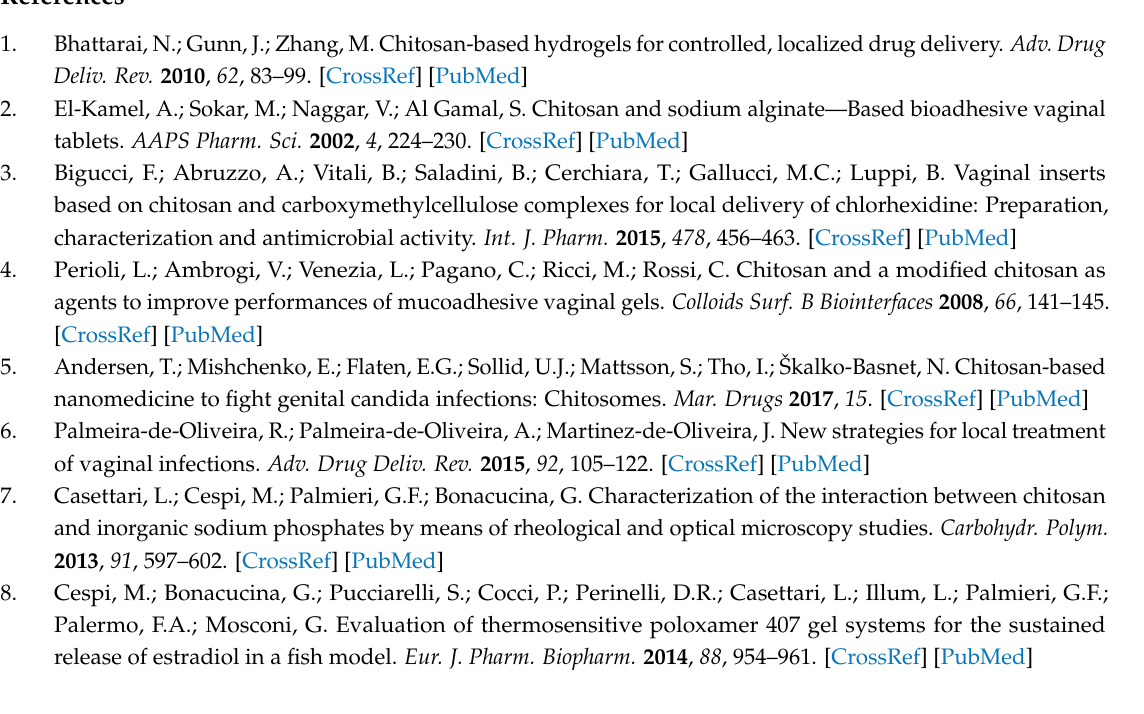
Figure S1: “Main effect” plot relative to the factors (CS % and CS/TPP ratio) influencing the size of nanoparticles, Figure S2: “Interactions plot” between the factors (CS% and CS/TPP ratio) influencing the size of nanoparticles, Figure S3: Hydrodynamic diameter (nm), counts (Kcps) and transmittance (%) of nanoparticles at different CS concentrations (0.1%, 0.5% and 1%; w/w ) and different CST/TPP ratio prepared in acetate buffer pH 5, Figure S4: Hydrodynamic diameter (nm), counts (Kcps) and transmittance (%) of nanoparticles at different CS concentrations (0.1%, 0.5% and 1%; w/w ) and different CST/TPP ratios prepared in acetate buffer pH 5.5, Figure S5: Image of the prepared HPMC/CS mixed hydrogels in 200 mM acetate buffer pH 4.5. From left to right: 5.5% HPMC (control); 5.5% HPMC/1%CS; 5.5% HPMC/1%CS NPs 12:1; 5.5% HPMC/1%CS NPs 6:1, Figure S6: Stress sweep (A) and frequency sweep (B) results obtained from HPMC/CS mixed hydrogels at 37 ◦ C. CS was dispersed into HPMC as free polymer, Table S1: Growth inhibition diameter (in mm) of Fluconazole (25 and 50 µ g/mL) tested against the different Candida spp. strains. Values are reported as the mean ± SD of two